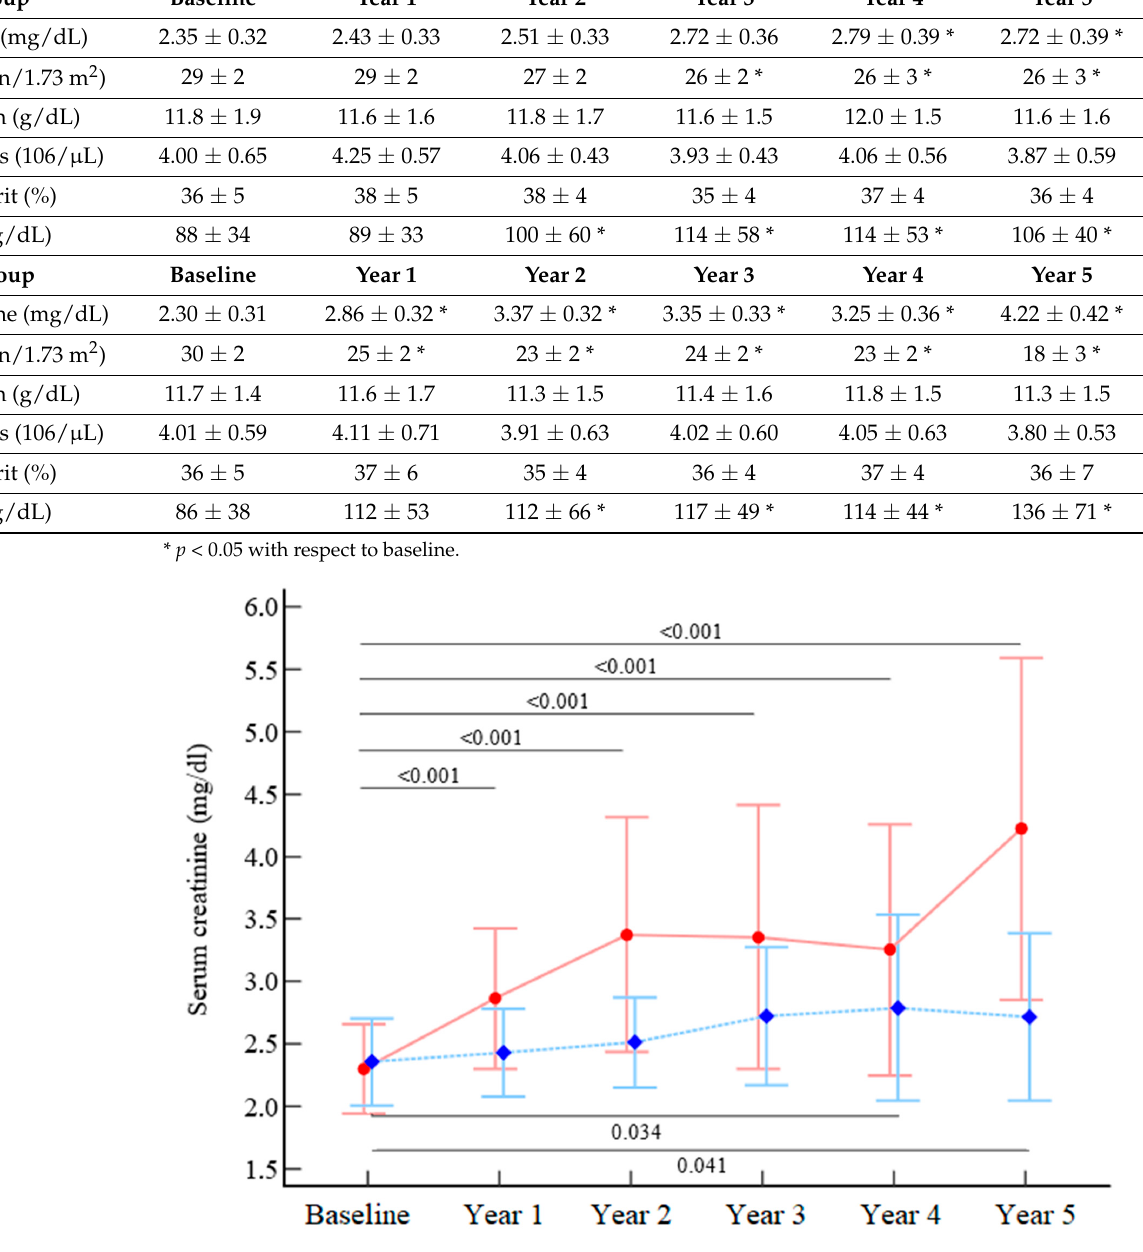
Figure 2. Variations over time in serum creatinine and eGFR in the two groups. Legend: red circle, control; blue diamond, exercise. Data are expressed as the mean and 95% confidence intervals.